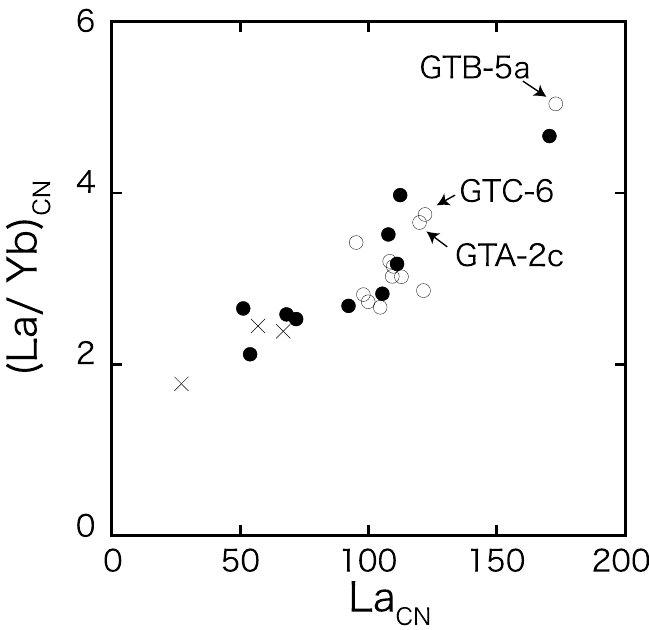
Figure 11. Chondrite-normalized La/Yb-La diagram for the rocks in the Hisakajima Island. CN — normalized to CI chondrite [25]. Solid circles — GD group samples. Open circles — HFG group samples.Cross marks — dike samples.